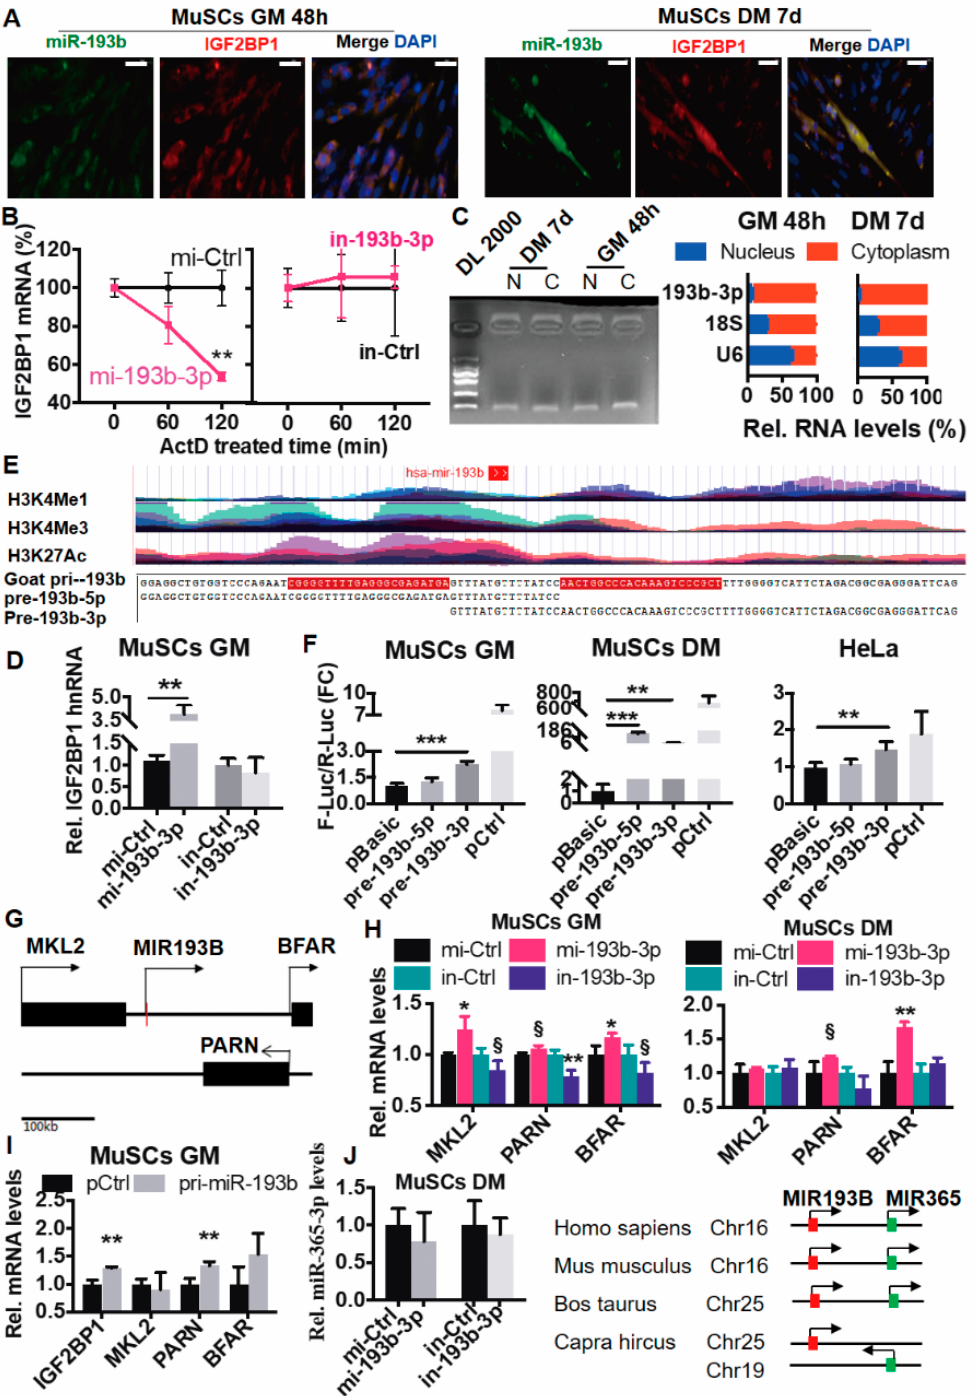
Figure 5. miR-193b-3p activates IGF2BP1 transcriptionally as an enhancer-related miRNA. ( A ) The overlapped signals of miR-193b-3p and IGF2BP1 mRNA. The Cy5-labeled probes target goat IGF2BP1 mRNA (red), and FAM-labeled chi-miR-193b-3p probes (green) are synthesized to localize them in MuSCs. The nucleus is stained with anti-DAPI (blue). Scale bar = 50 µ m. ( B ) miR-193b-3p destabilizes IGF2BP1 mRNA. ( C ) miR-193b-3p distributes in both cytoplasm and nucleus. N, Nucleus; C, Cytoplasm. ( D ) miR-193b-3p promotes levels of IGF2BP1 hnRNA. ( E ) Human miR-193b (hsa-mir-193b) is located in the enhancer region. The upper panel, hsa-mir-193b sits in the peak and valley of H3K4Me1/H3K4me3/ H3K27ac derived from 7 cell lines in ENCODE UCSC. Lower panel, the sequence of goat pri-miR-193b and pre-miR-193b-5p and 3p. ( F ) Pre-miR-193b-3p induces gene expression. Promoter vectors including pre-193b-3p, pre-193b-5p as well as the blank (pBasic) and control (pCtrl) (1.28 μ g /mL) were transfected into MuSC and HeLa, and F-Luc/R-Luc levels were measured 48 h post transection. ( G ) Neighboring genes of miR-193b-3p, including MKL2, BFAR,